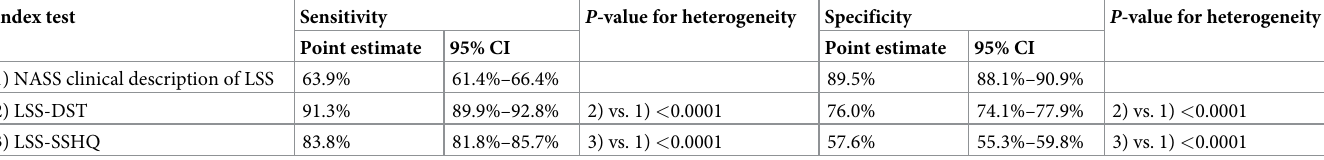
Table 4. Sensitivity and specificity of the NASS clinical description of LSS, LSS-DST, and LSS-SSHQ.